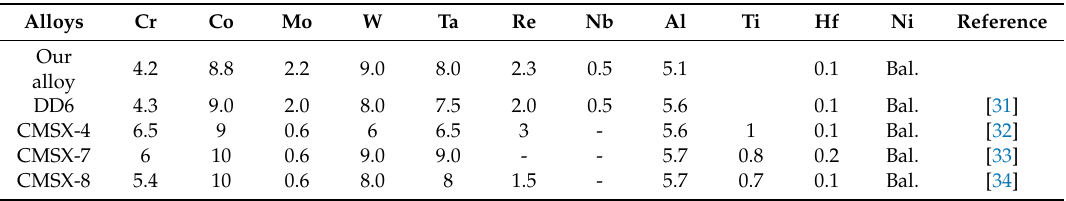
Table 1. Measured composition (wt.%) of our alloy in this study and nominal composition of some other second-generation Ni-based single crystal